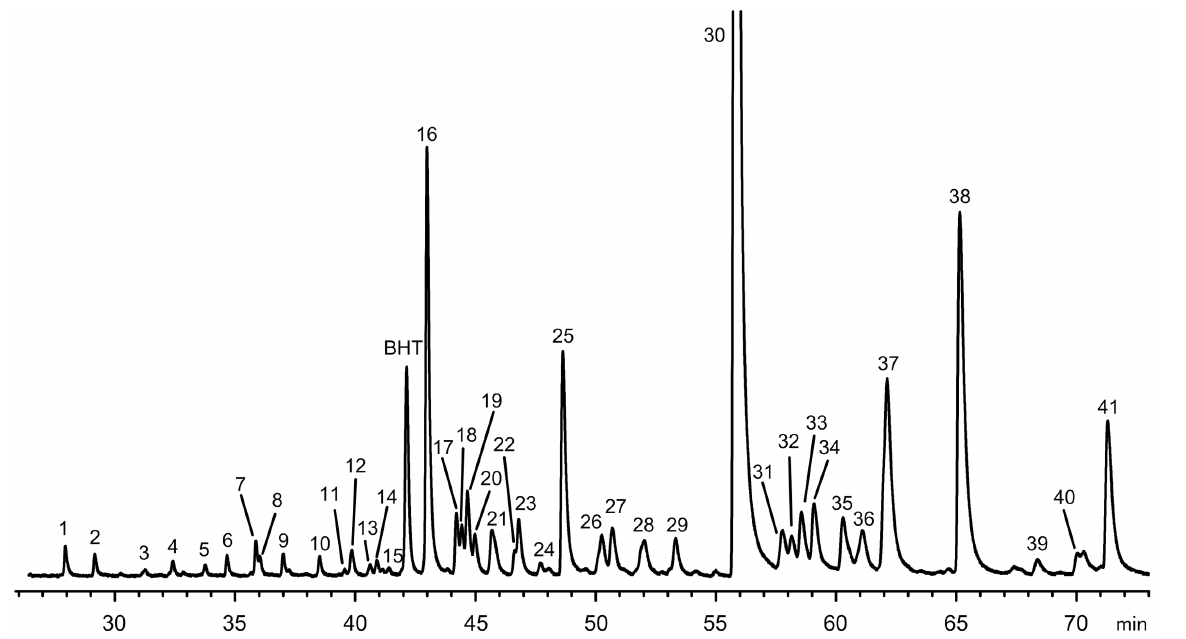
Figure 2. Partial gas-liquid chromatogram of the branched chain fatty acid region of the fat tail in Damara Ram lambs. Peak identification: 1) 10:0; 2) 10:0-4Me and 10:0–6Me; 3) 11:0; 4) 11:0–4Me; 5) 11:0–4,8Me; 6) 12:0; 7) 12:0–4Me; 8) 12:0–8Me; 9) 12:0–4,8Me; 10) 13:0;